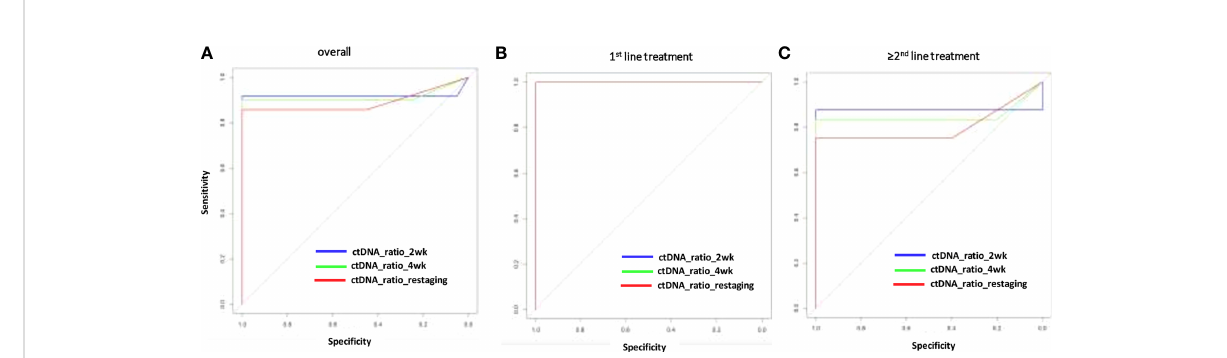
FIGURE 2 Sensitivity and speci fi city (ROC analysis) for response prediction by ctDNA reduction during systemic treatment. Relative ctDNA reductions at 2 or 4 weeks or restaging for the overall population (A) , the fi rst – line treatment population (B) for patients with >1 treatment line (C) . AUC, area under the curve; ctDNA, circulating tumor DNA; MAF, mutant allele frequency; ROC, receiver operating